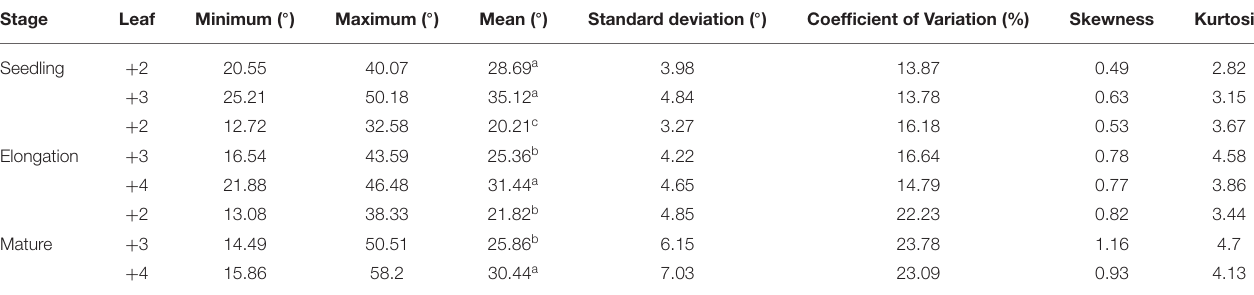
TABLE 1 | Variation of sugarcane leaf angle at different growth stages in the panel of 216 sugarcane core parents and their derived lines. Stage Leaf Minimum ( ◦ ) Maximum ( ◦ ) Mean ( ◦ ) Standard deviation ( ◦ ) Coefficient of Variation (%) Skewness Kurtosis Seedling + 2